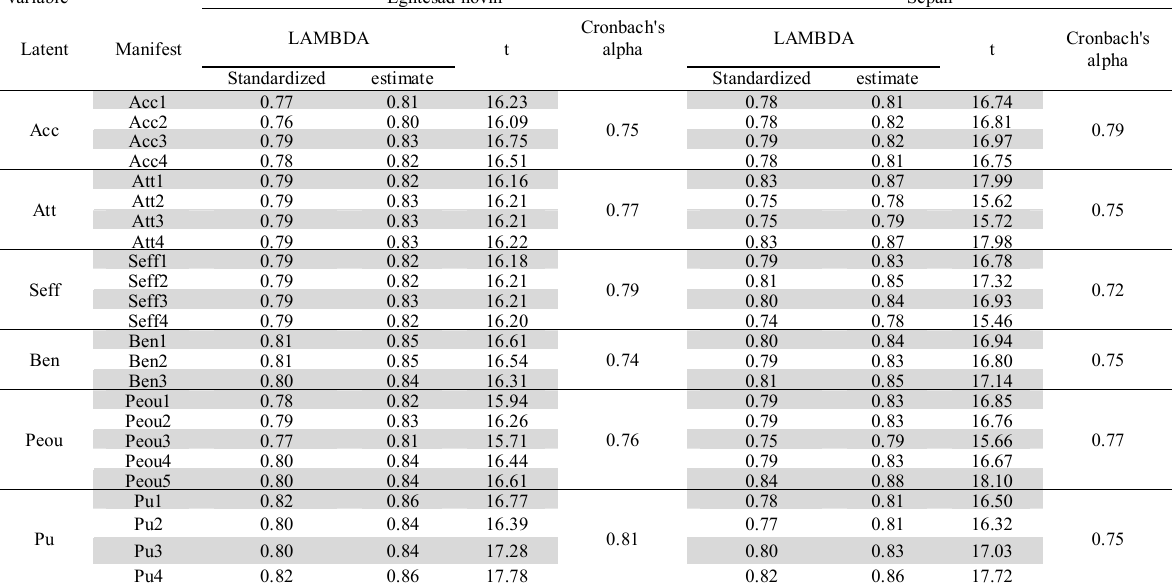
The summary of statistical observations on testing various